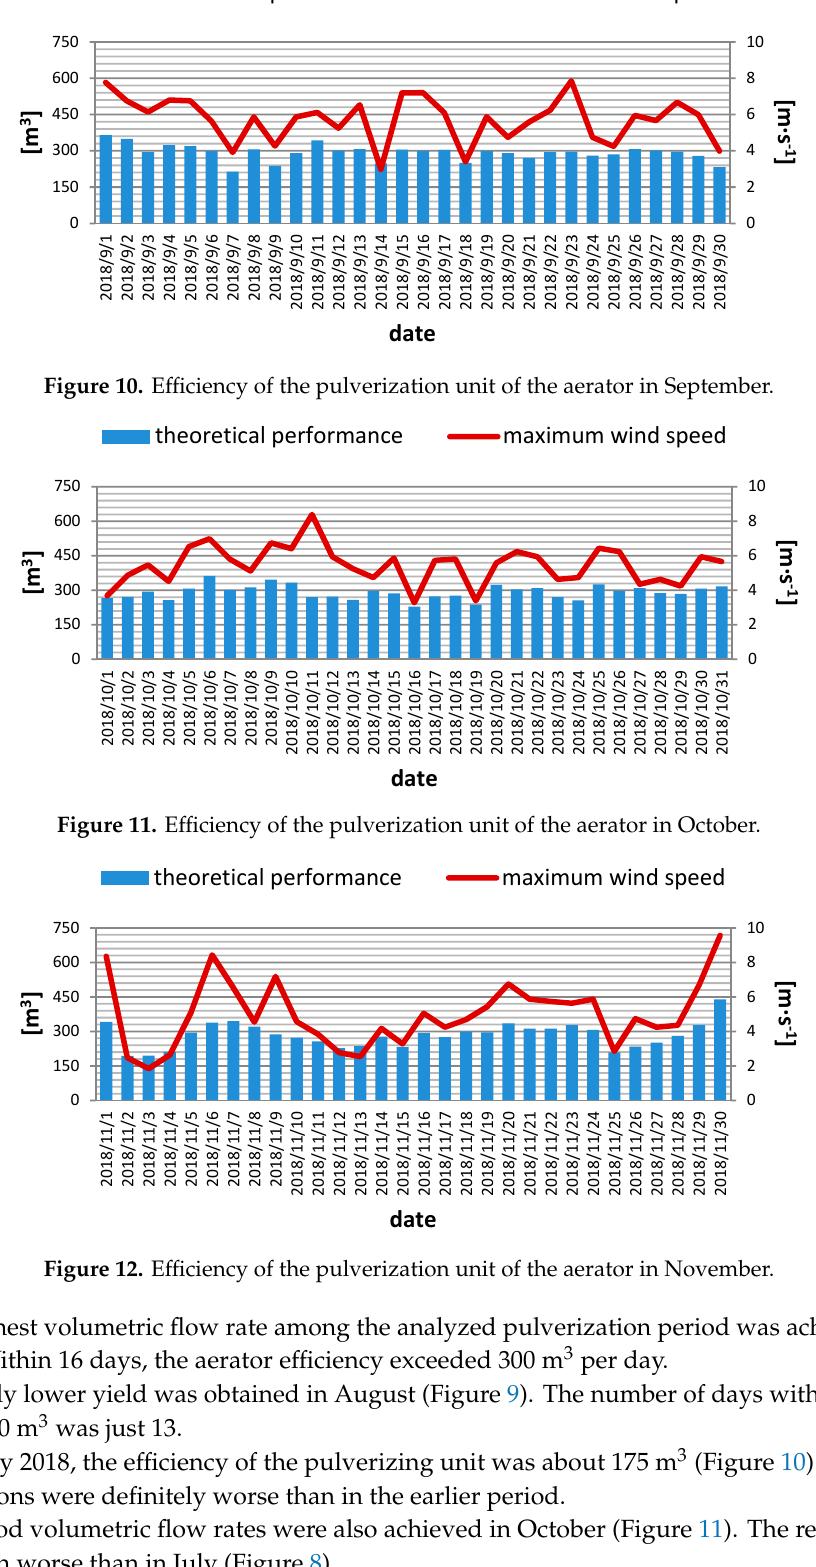
Figure 12. Efficiency of the pulverization unit of the aerator in November.